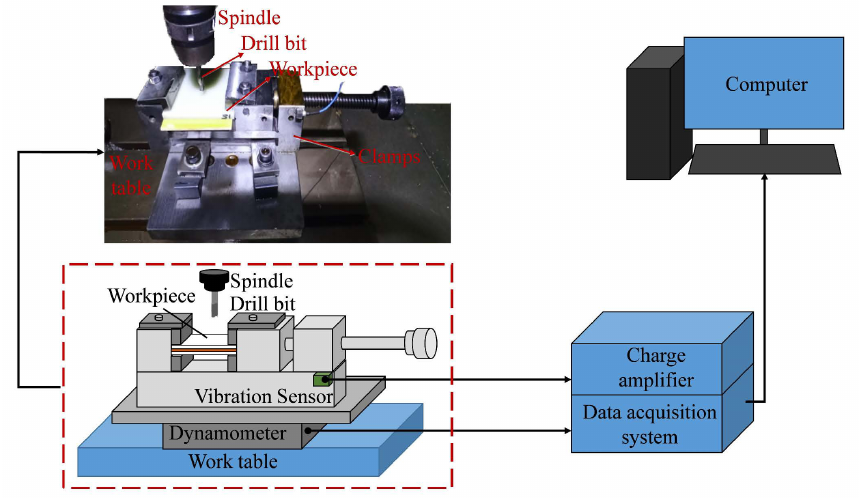
Figure 2. The experiment